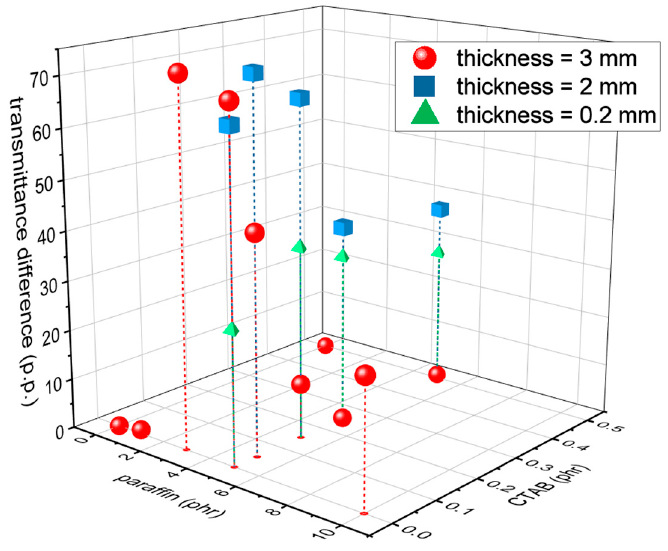
− T 23 ◦ C ) measured in percentage points 550 nm 550 nm